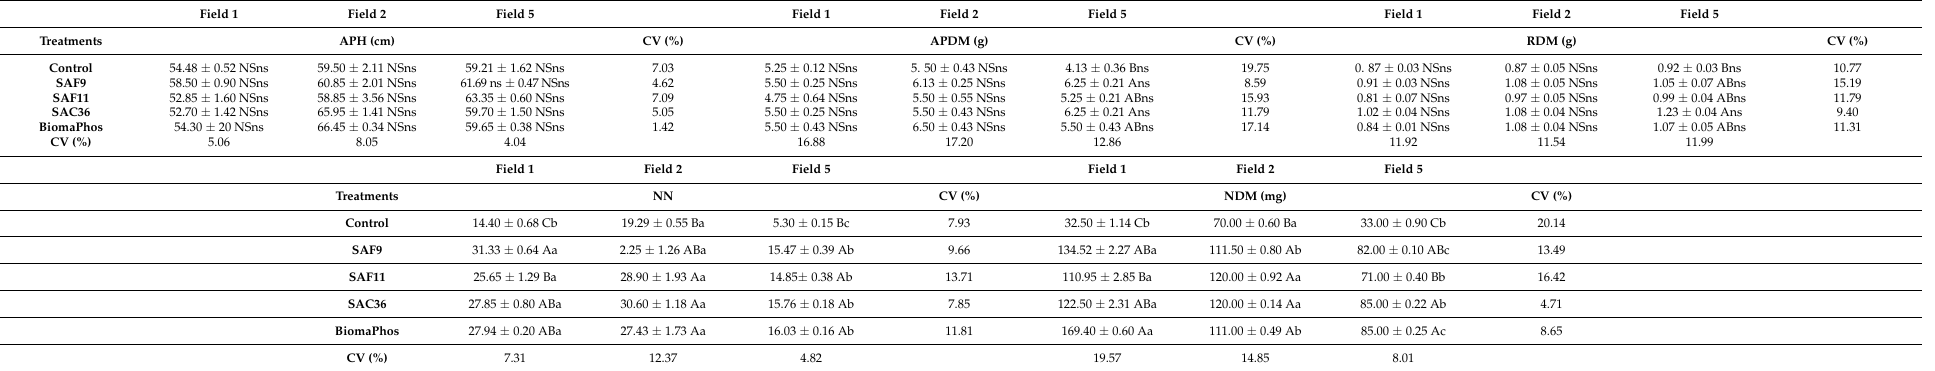
Table 2. Effect of inoculation with plant-growth-promoting rhizobacteria on aerial part height (APH), aerial part dry mass (APDM), root dry mass (RDM), number of nodules (NN), and nodule dry mass (NDM) on Glycine max L. plants grown in summer 2019/2020, in three experimental fields of soybean cultivation, in the interior of the state of Goi á s, Brazil, with different soybean cultivation time histories: Field 1, soybean production for 30 years; Field 2, soybean production for 15 years; and Field 5, first year of soybean